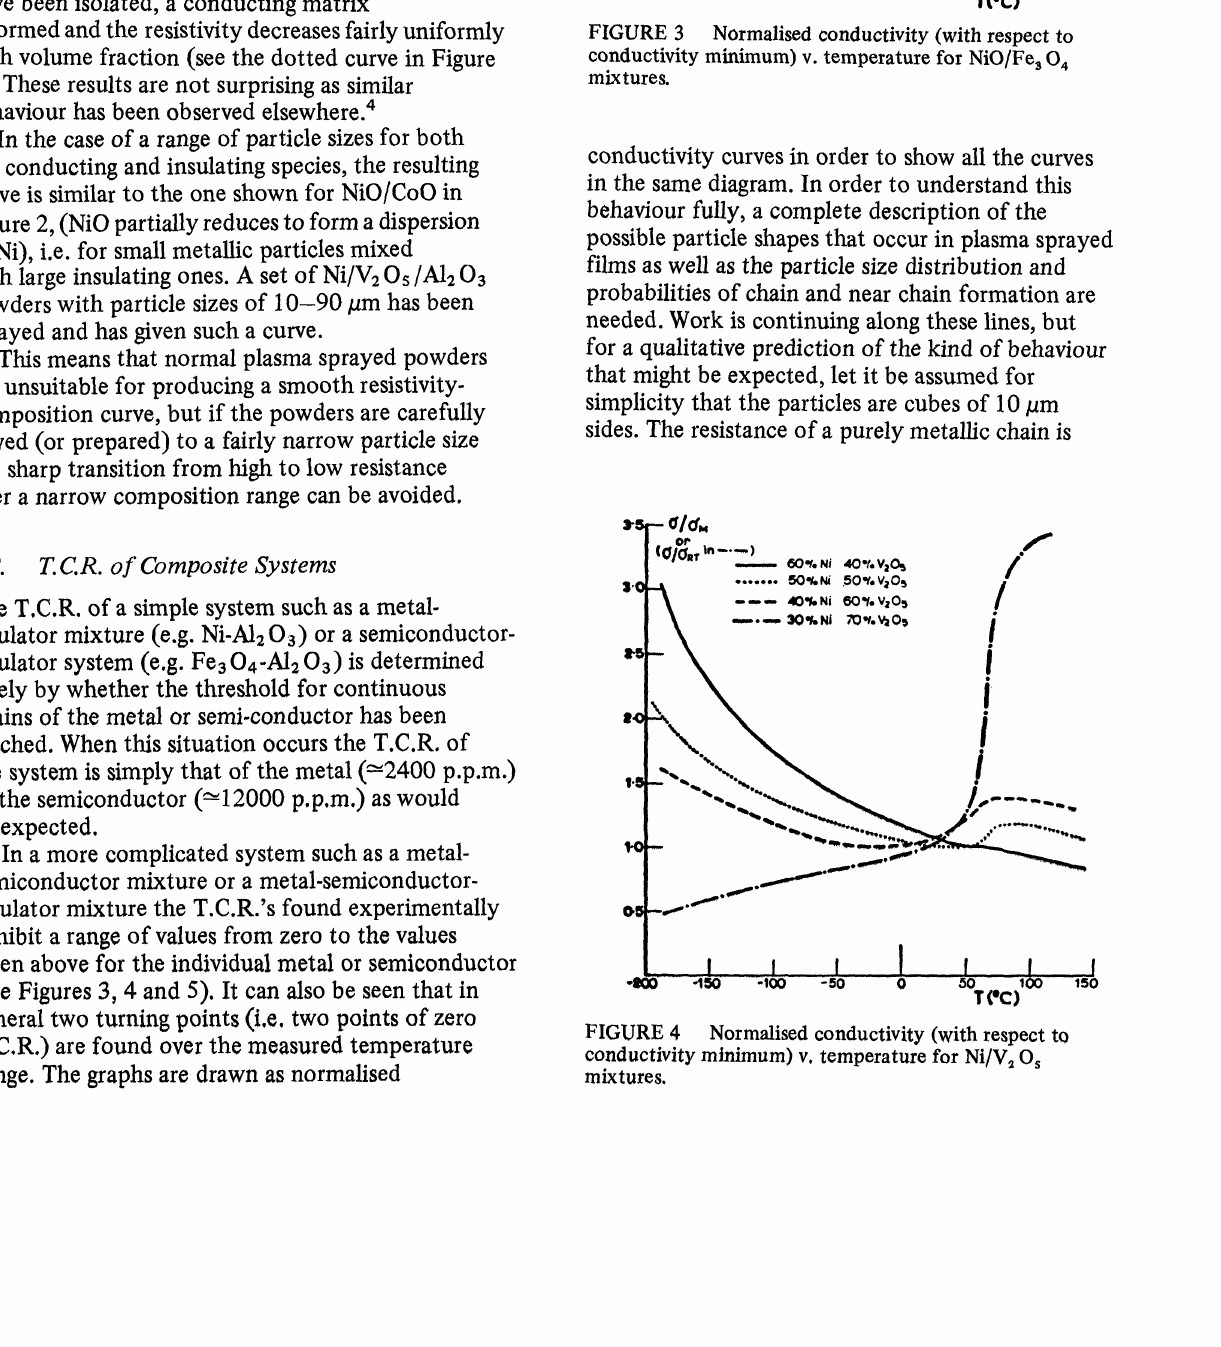
Normalised conductivity (with respect to conductivity minimum) v. temperature for NiO/Fe O mixtures.